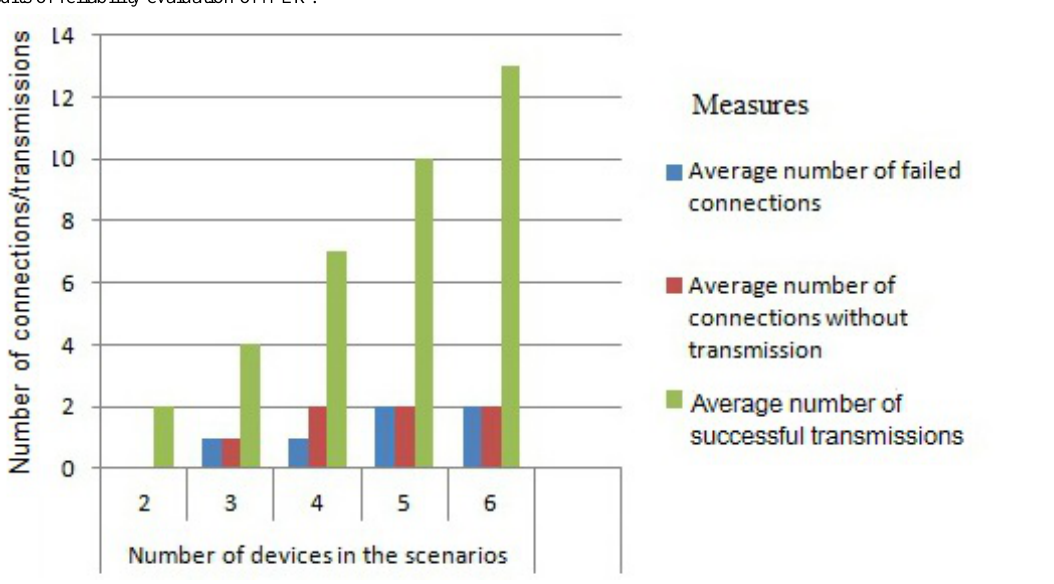
Figure 9. Results of reliability evaluation of MEK.